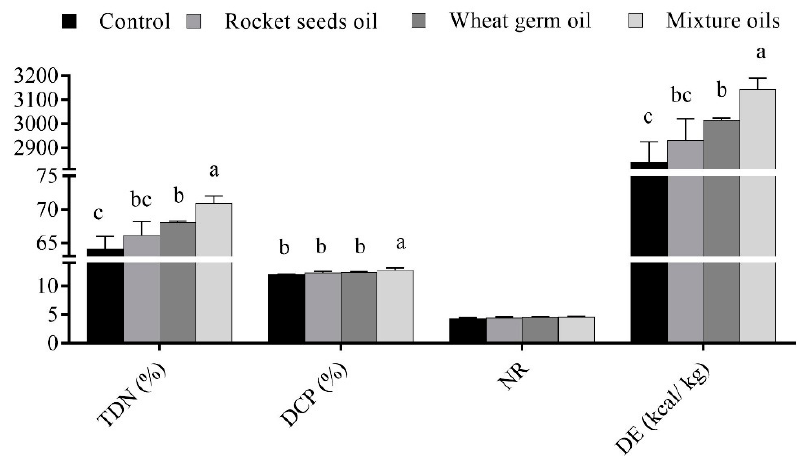
Figure 2. Nutritive value and digestible energy of experimental diets of V-line growing rabbits (5–12 weeks of age) that were administered orally with rocket seed oil, wheat germ oil, and their mixture. Columns marked with different superscripts are significantly different at p ≤ 0.05. TDN: Total digestible nutrients; DCP: Digestible crude protein; NR: Nutritive value; DE: Digestible energy.